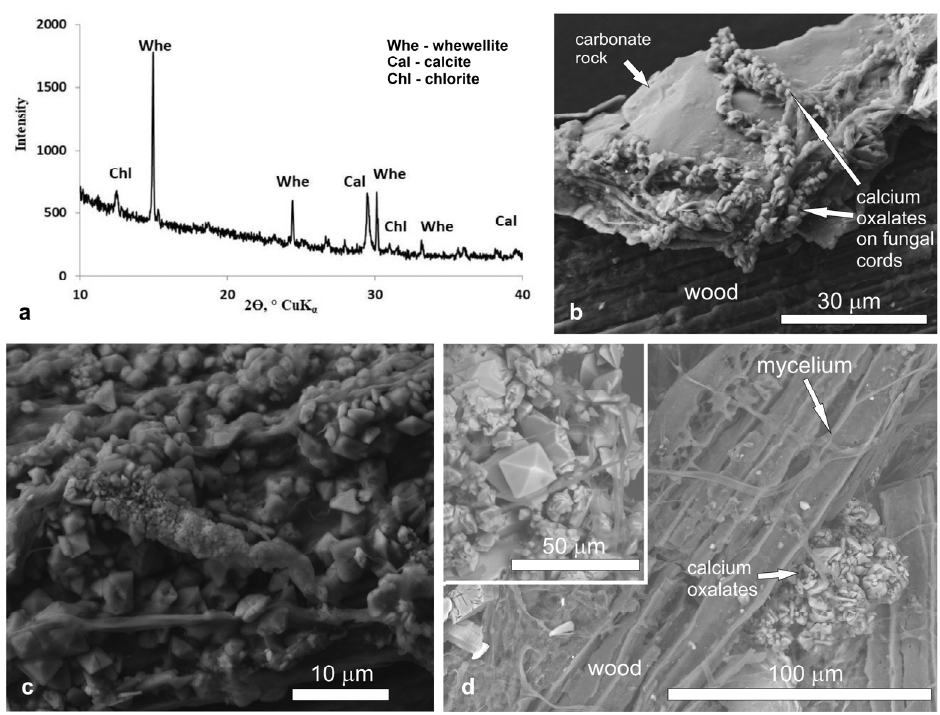
Figure 2. X-ray diffraction pattern ( a ) and SEM images ( b – d ) of calcium oxalates in the Rogoselga adit: ( b )—underlying substrate (old timber and adjoining carbonate rock) with brown rot fungi and calcium oxalates on fungal cords; ( c ) numerous small crystals of whewellite and weddellite on fungal cords localized mainly on carbonate rock; ( d )—large dipyramidal crystals of weddellite (incut) among numerous small crystals of whewellite on old timber.